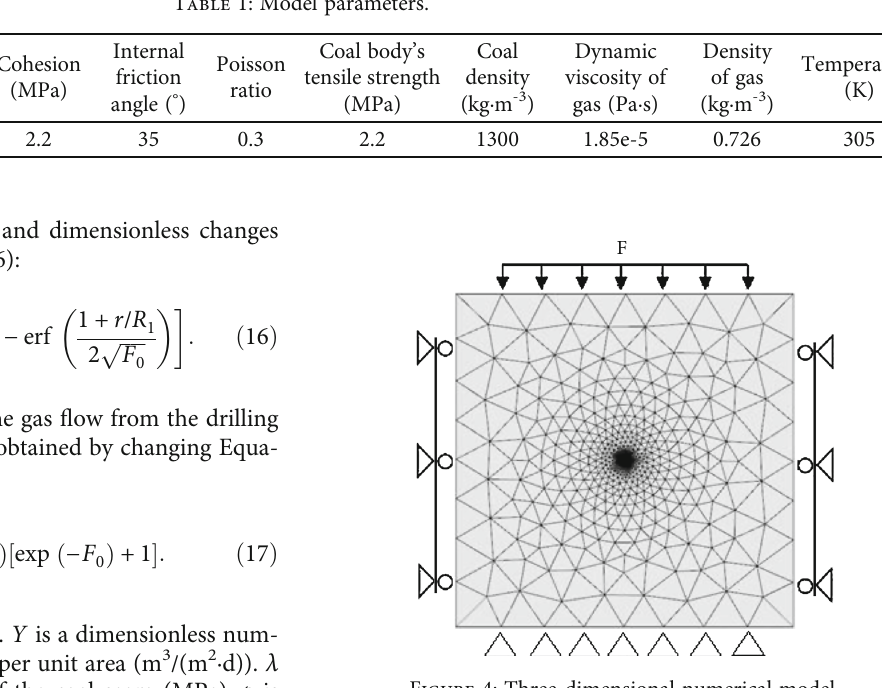
Table 1: Model parameters.